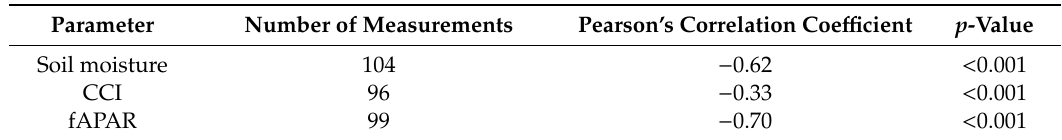
Table 4. Pearson’s correlation coe ffi cient for the relation between CWSI and field measurement with its p -value and number of measurements used for